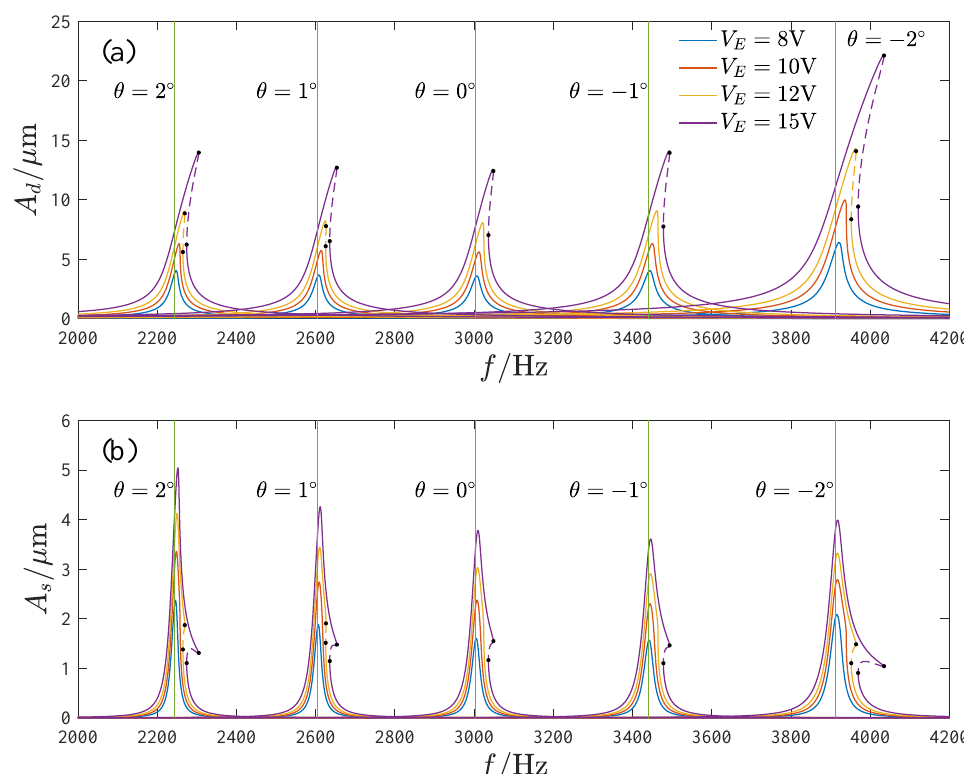
Figure 18. The amplitude–frequency curves corresponding to different voltage and inclination angles, ( a ) The amplitude-frequency curves in the driving direction, ( b ) The amplitude-frequency curves in the sensing direction.